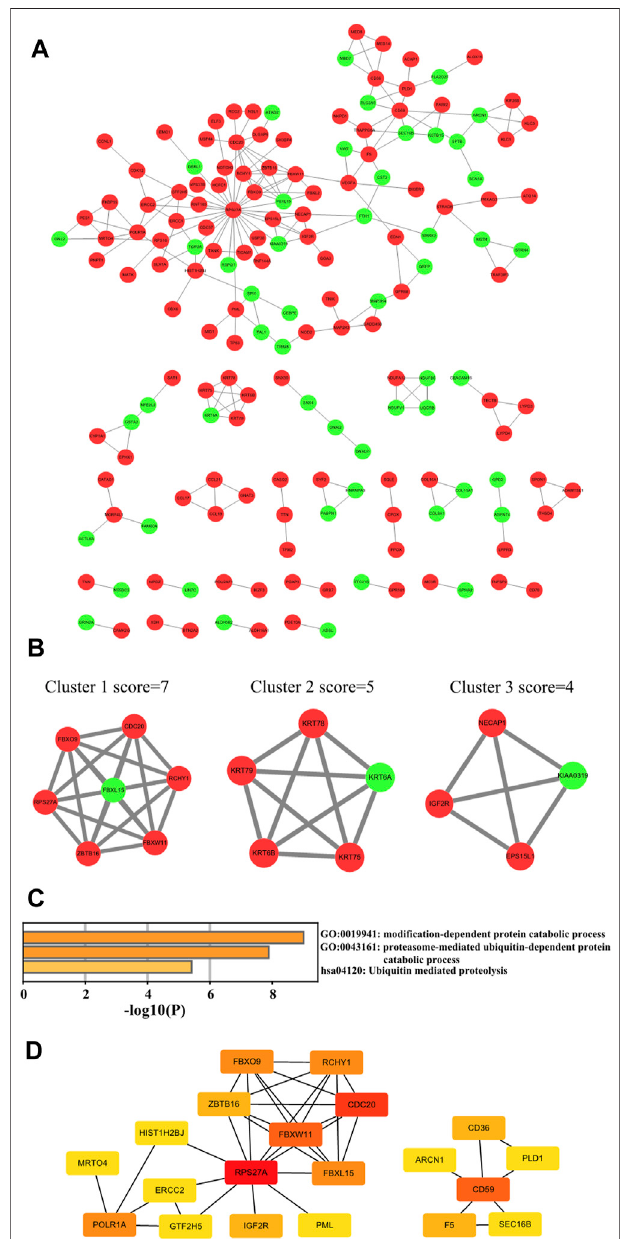
FIGURE 5 | PPI network construction of intersected DEGs. (A) Cytoscape software visualizing the PPI network. Note: Red means upregulated and light green means downregulated. (B) Top three cluster networks in PPI. (C) Functional enrichment analysis of Cluster 1 core networkgenes. (D) Top 20 hub genesin the PPInetworkofintersected DEGs in KC. Note: the color change from red to yellow represents the hub gene degree score from high to